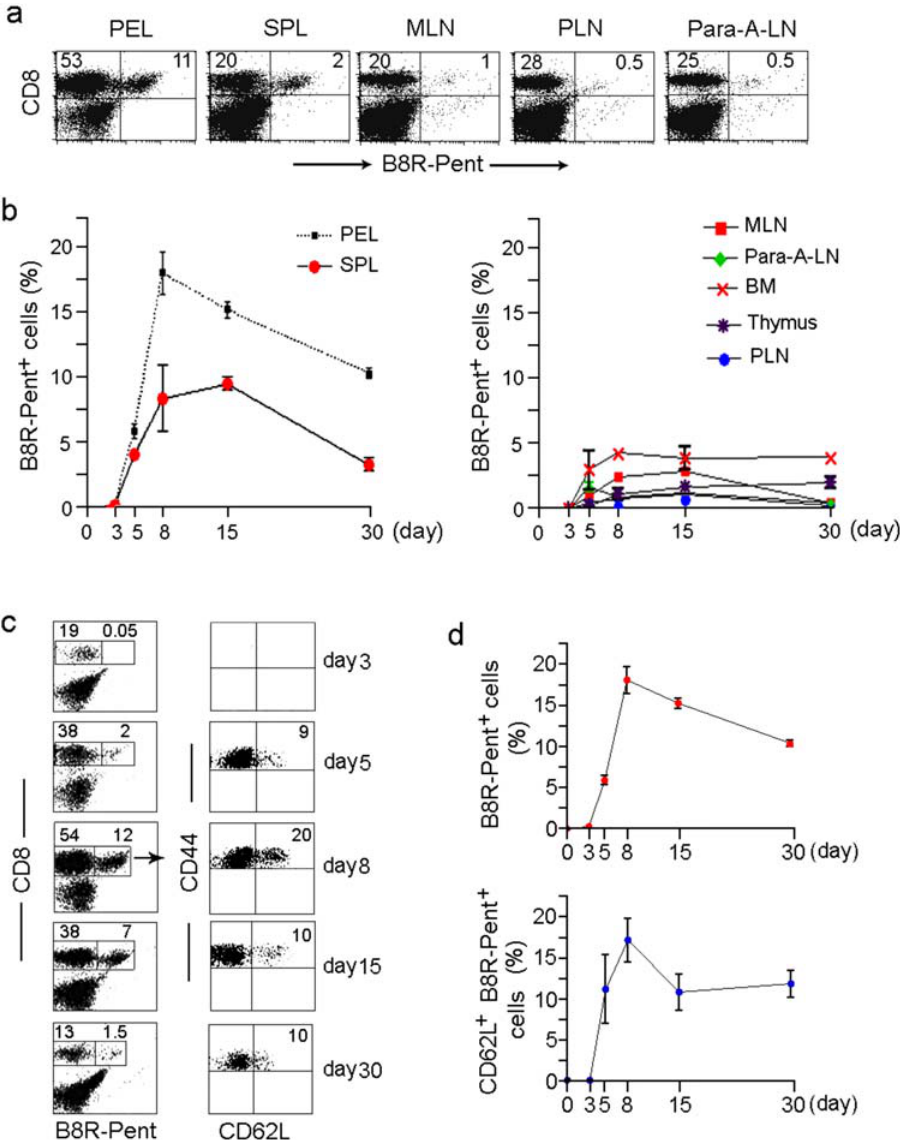
Figure 2. Kinetics and phenotype of antigen-specific CD8 + T response during an acute infection with vaccinia virus. C57BL/6 mice were i.p. infected with vv and at different time points after infection, the presence of B8R 20–27 pentamer + CD8 + T cells in different tissues was assessed by flow cytometry. Representative dot plot of results on day 8 (a) and cumulative data from 12 mice at different time points (b) on the presence of B8R 20–27 pentamer + CD8 + T cells are shown (SPL, spleen; BM, bone marrow; PLN, peripheral (inguinal and axillaries) lymph nodes; MLN, mesenteric lymph node; Para-A-LN, Para aortic lymph node). (c) Mice were infected with vv as in (a) and at indicated times post-infection, their PELs were tested for the presence and phenotype of B8R 20–27 CD8 + T cells. Representative dot plots in the left panel show the percent of B8R 20–27 pentamer + CD8 + T cells and the right panel shows CD62L and CD44 expression by the B8R 20–27 pentamer + CD8 + gated cells ( n =4). ( d ) shows the cumulative data